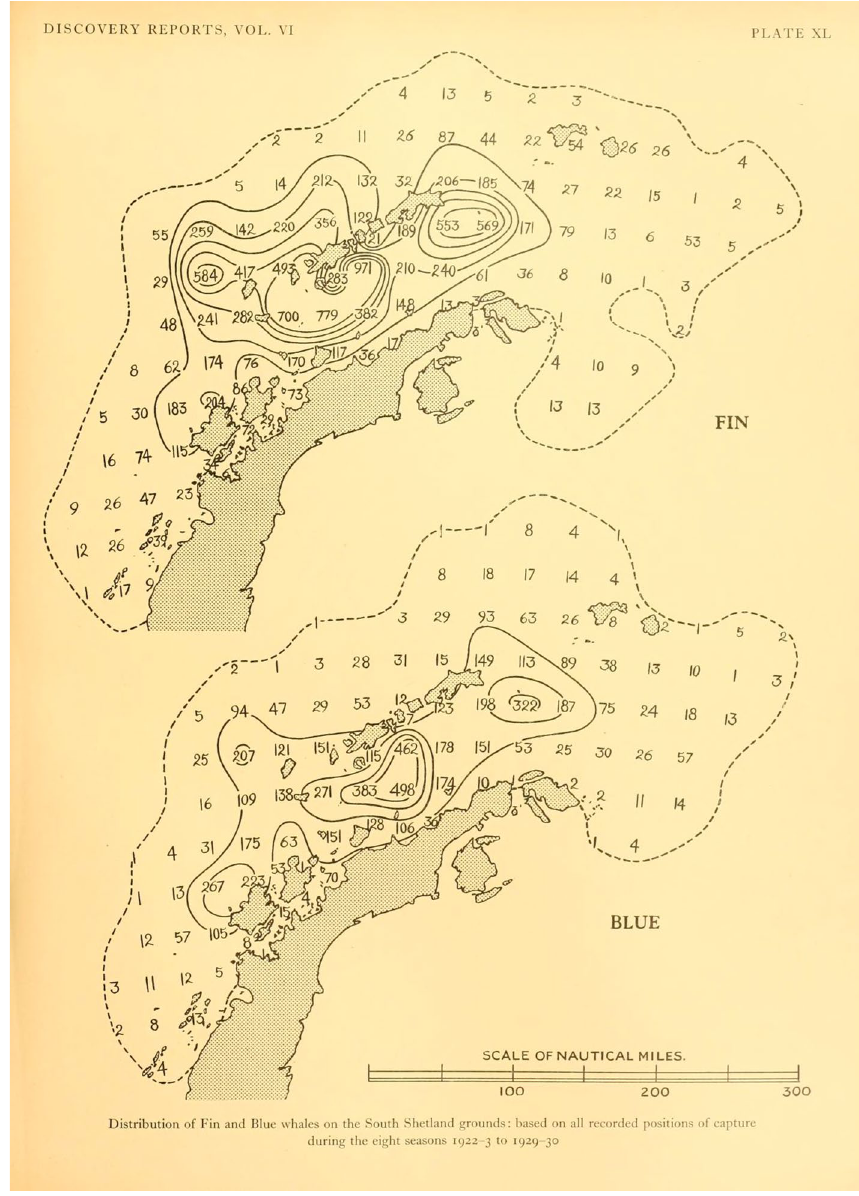
Figure 8. Original map from Kemp and Bennett (1932), showing the distribution of catches of blue and fin whales around the Western Antarctic Peninsula for the decade of the 1920s. It is apparent that historically, fin whales ranged inshore and in the Gerlache and Bransfield Strait in high